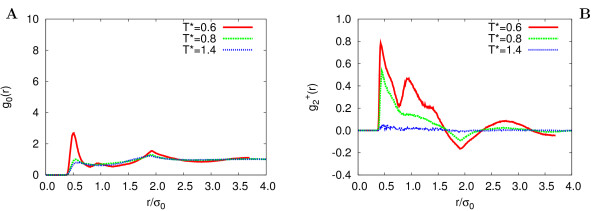
HT-AT, Correlation functions. Radial correlation function g0(r) (A) and second rank anisotropy g2+(r)
 MathType@MTEF@5@5@+=feaafiart1ev1aaatCvAUfKttLearuWrP9MDH5MBPbIqV92AaeXatLxBI9gBaebbnrfifHhDYfgasaacH8akY=wiFfYdH8Gipec8Eeeu0xXdbba9frFj0=OqFfea0dXdd9vqai=hGuQ8kuc9pgc9s8qqaq=dirpe0xb9q8qiLsFr0=vr0=vr0dc8meaabaqaciaacaGaaeqabaqabeGadaaakeaacqWGNbWzdaqhaaWcbaGaeGOmaidabaGaey4kaScaaOGaeiikaGIaemOCaiNaeiykaKcaaa@332D@ (B) from MC simulations of system Q2 at T* = 0.6 (red continuous line), 0.8 (green dotted line), 1.4 (blue dashed line).